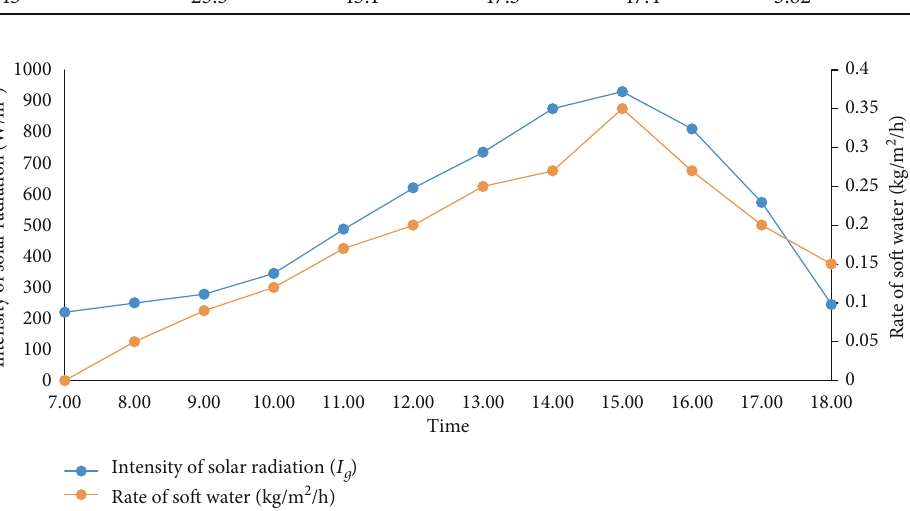
Figure 4: Rate of generation and solar intensity versus time (Al foil on CPC).